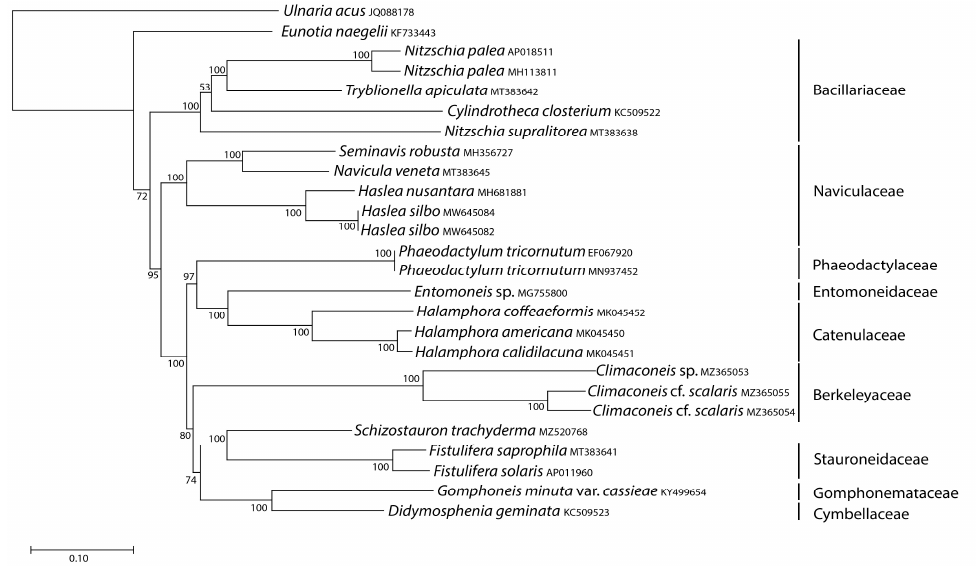
Figure 8. Maximum likelihood phylogeny inferred from an alignment of concatenated protein-coding genes from 26 plastid genomes of diatoms, including that of S. trachyderma . The araphid species Ulnaria acus served as an outgroup in this analysis. The best scoring RAxML tree (log likelihood = − 878702.878358) is presented with bootstrap support values denoted on the nodes. The scale bar indicates the number of substitutions per site.